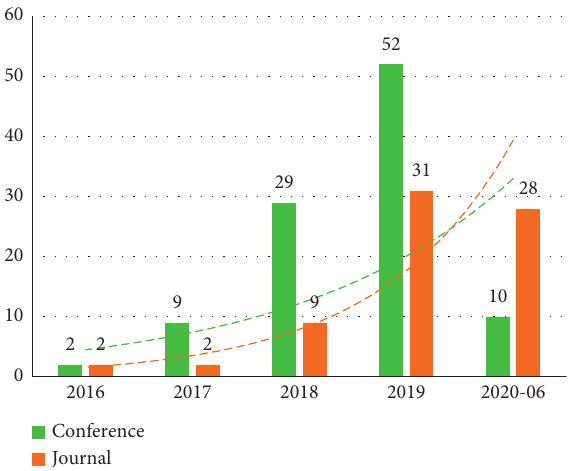
Figure 2: Paper distribution by year of